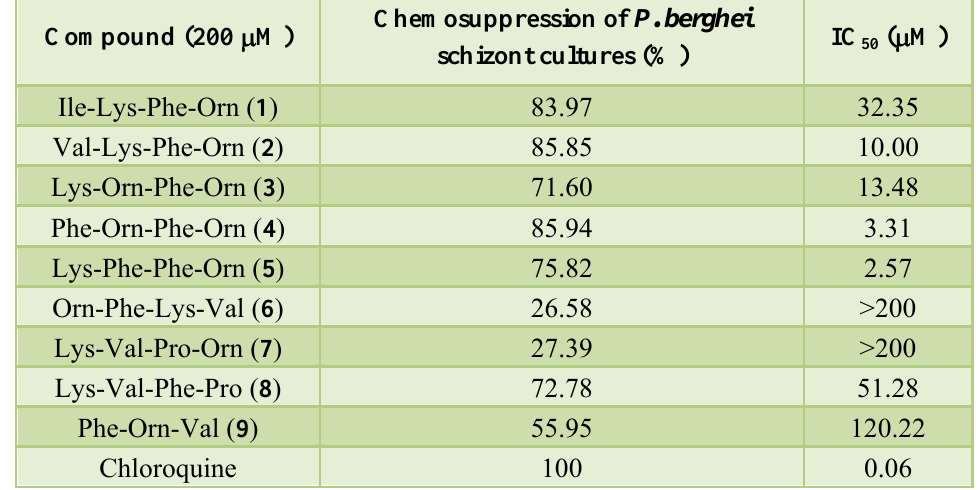
Table 1. Chemosuppression of P. berghei schizont cultures of peptides 1 - 9 after 16